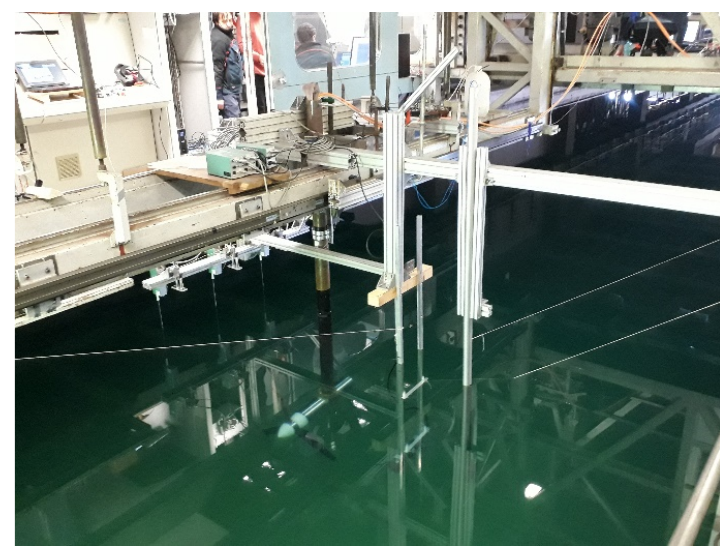
Figure 1. Test setup in the CNR-INM wave-tow facility. Horizontal-axis turbine mounted on the tow carriage via stanchion with a set of ultrasonic wave probes on the left.